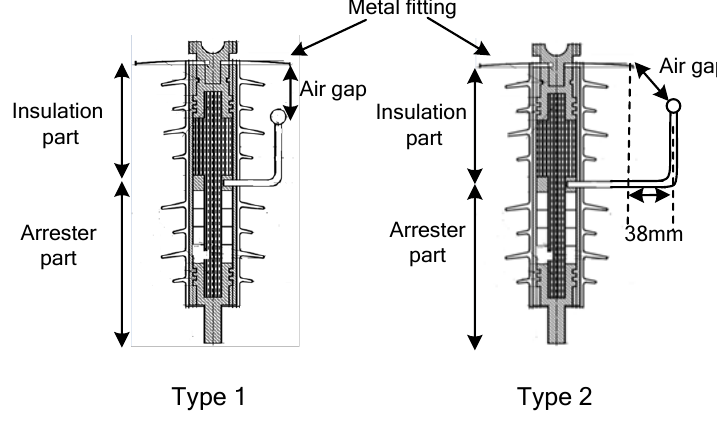
Figure 2. Profiles of the test specimens.